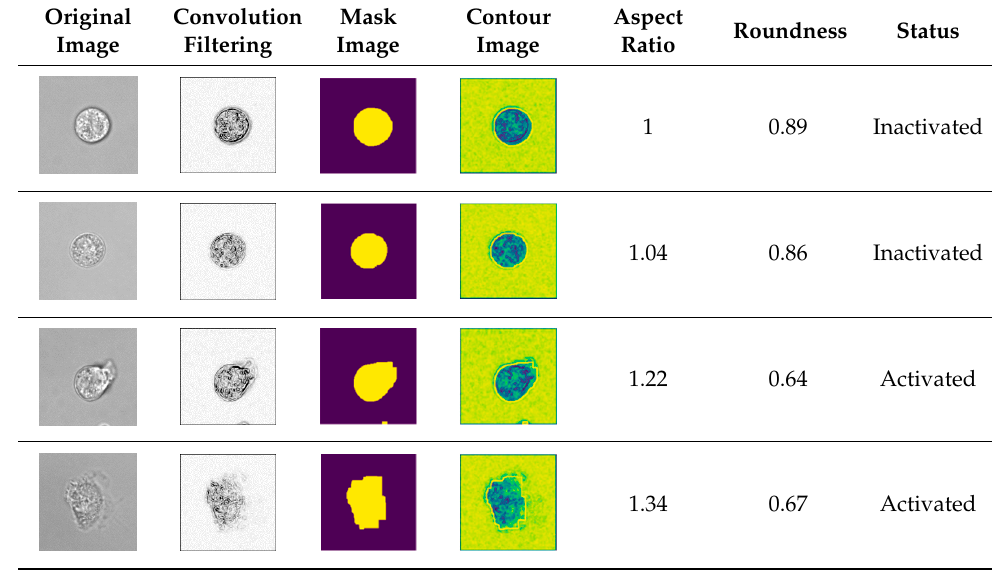
Table 2. The identification process of activated or inactivated WBCs. Original